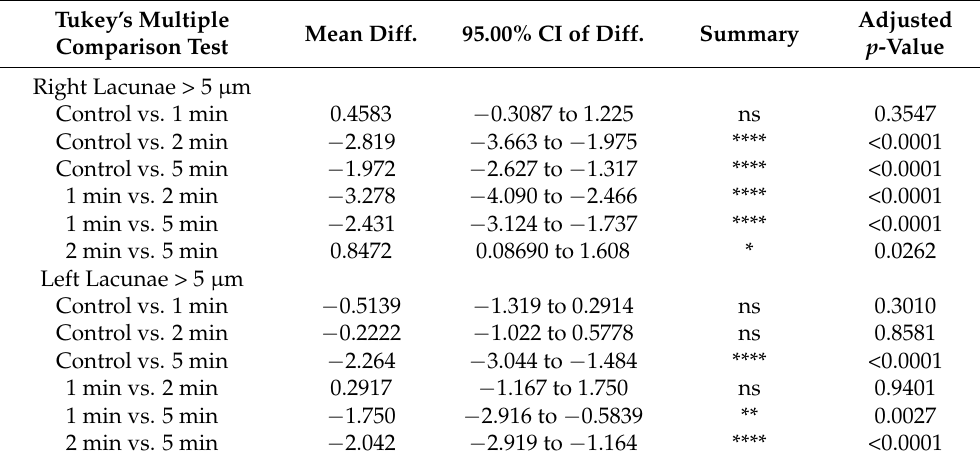
Figure 6. Larger than 5 µ m lacunae graphs of the left and right tibia. ( p ≤ 0.01) as ** and ( p ≤ 0.0001) as ****. Table 4. Larger than 5 µ m lacunae table of the left and right tibia.